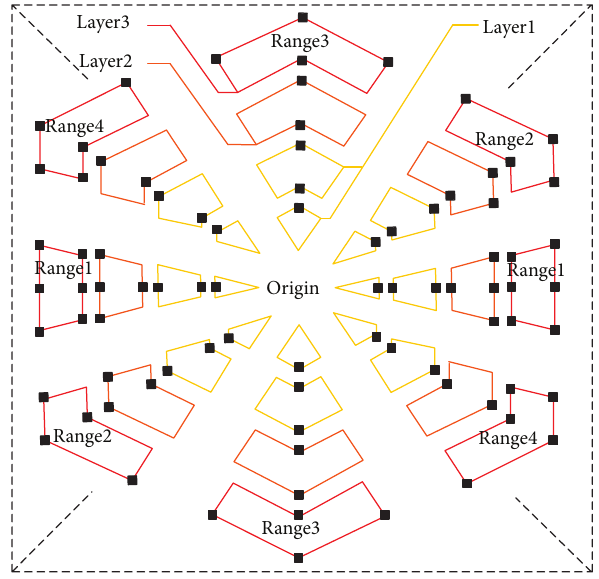
Figure 6: Modified uneven multihexagon-grid search